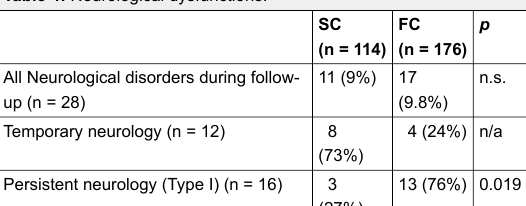
Table 4: Neurological